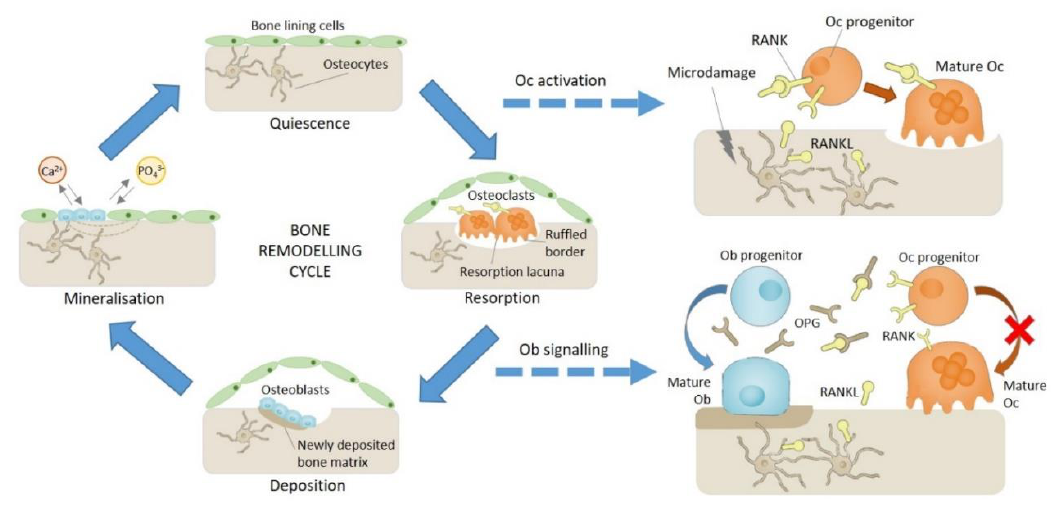
Figure 1. Schematic representation of the bone remodelling process [18]. Legend: osteoblasts (Ob); osteoclasts (Oc); receptor activator of nuclear factor-ĸΒ (RANK); receptor activator of nuclear factor-ĸΒ ligand (RANKL); osteoprotegerin (OPG).